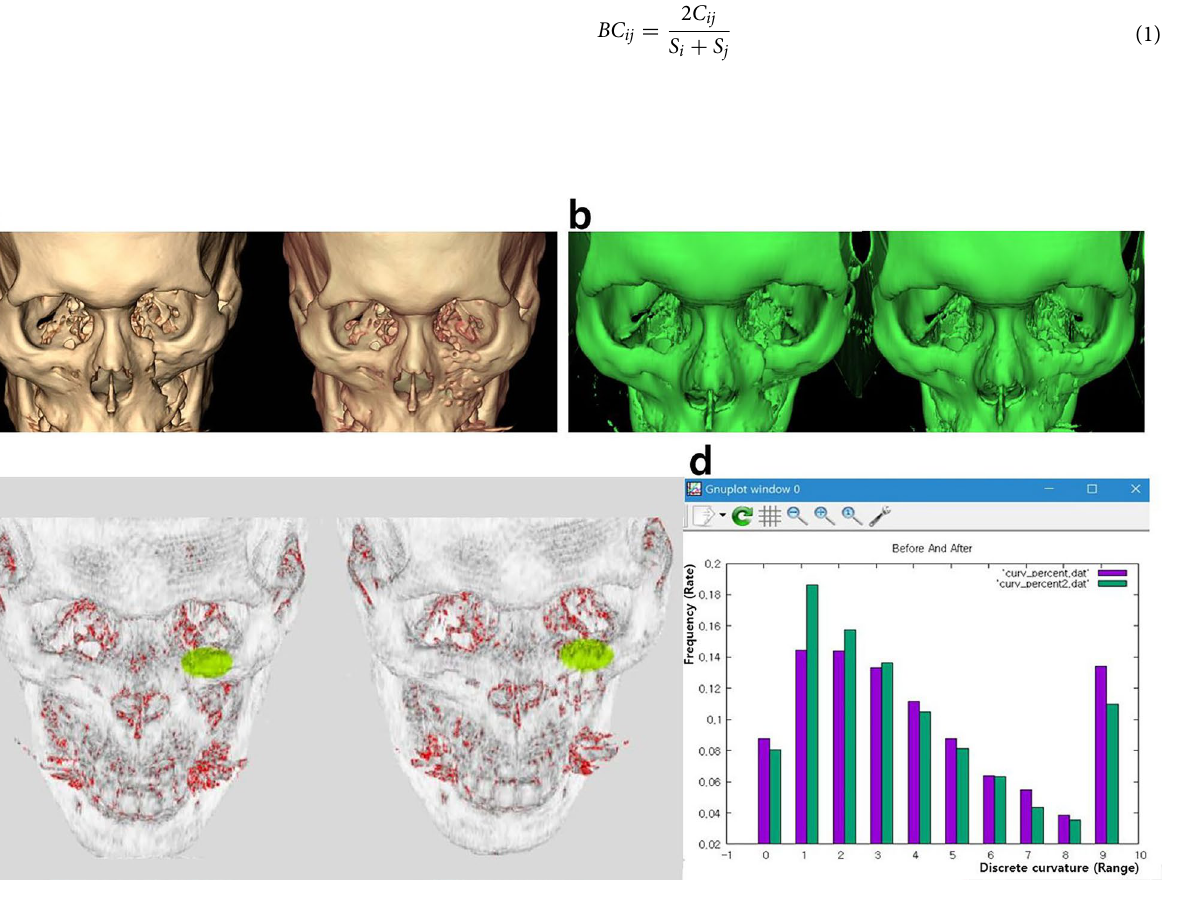
Figure 1. Analysis of the inferior orbital rim. ( a ) Fractured left inferior orbital rim was exhibited preoperatively and displaced segment was reduced postoperatively. ( b ) The initial medical images in a DICOM file format were converted into OBJ files. ( c ) During image processing, a specific area (the part reduced during surgery) was selected and the vertices included in the selected area were displayed in fluorescent green. ( d ) The discrete curvature mainly showed large values preoperatively (purple bars), and the range shifted toward smaller values postoperatively (green bars). The range of large values-high curvature (from 4 to 9) was more dominant preoperatively, and the range of small values-low curvature (from 1 to 3) postoperatively. The weighted average of curvature changed from 0.52 to